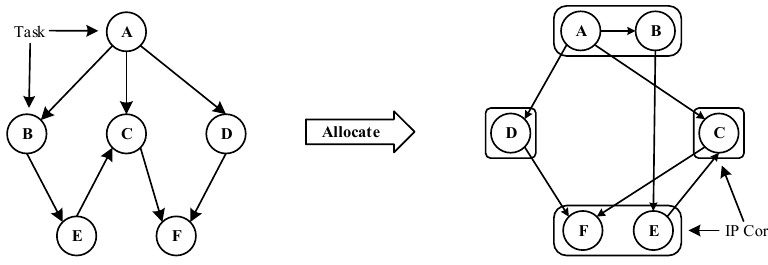
Figure 1. The first step of Network-on-Chip (NoC) mapping: task assignment .